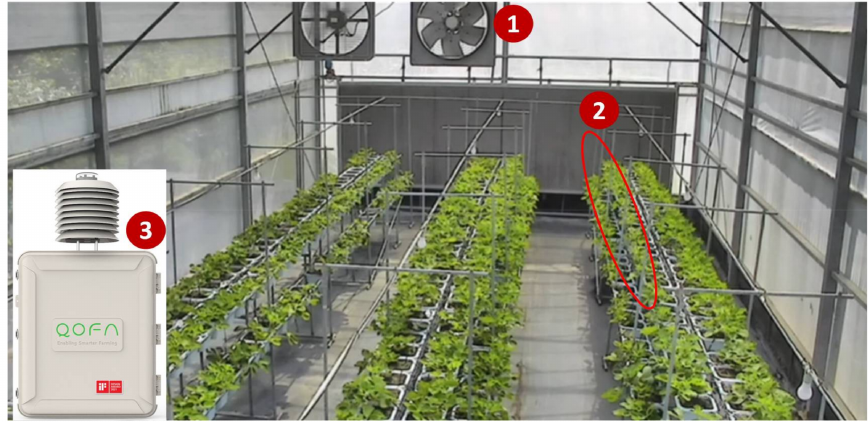
Figure 18. The sensors and actuators of the greenhouse on Bao Mountain,